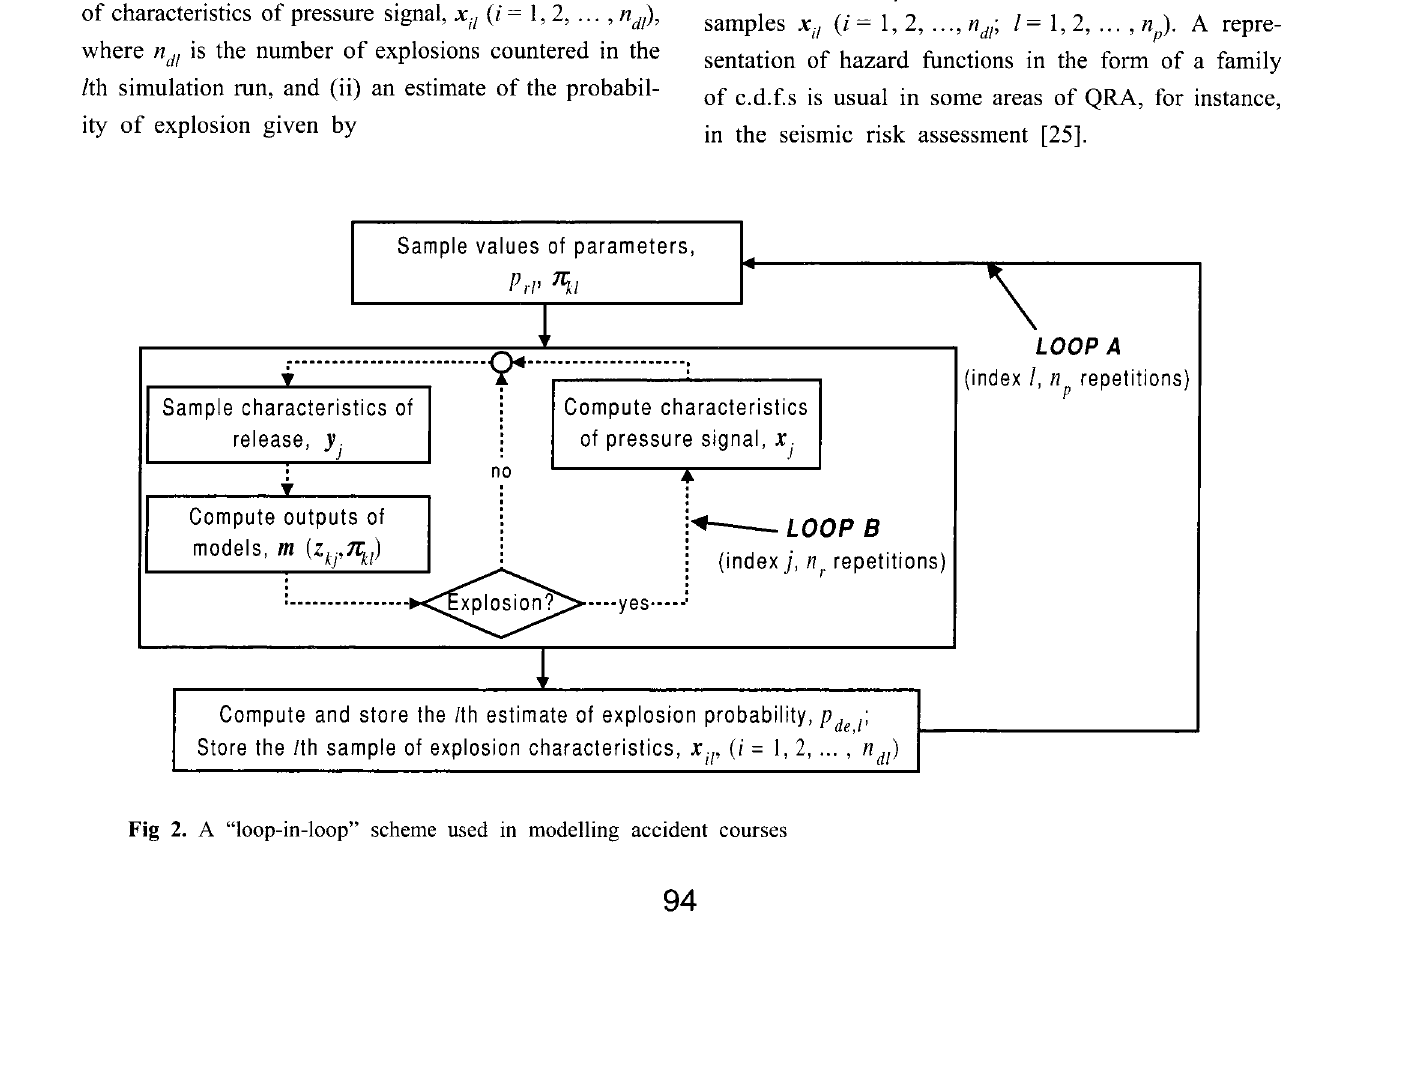
Fig 2. A "loop-in-loop" scheme used in modelling accident